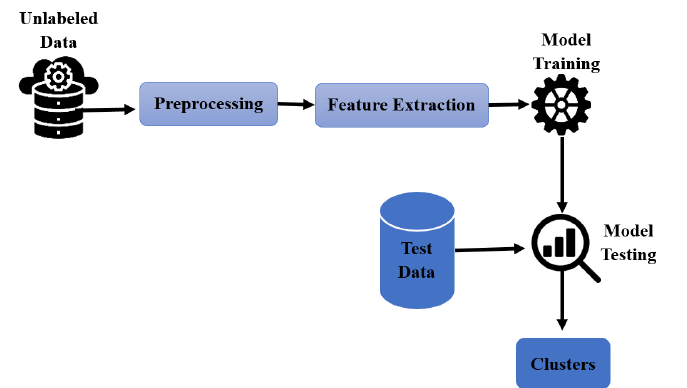
Figure 7. Architecture of Unsupervised Machine